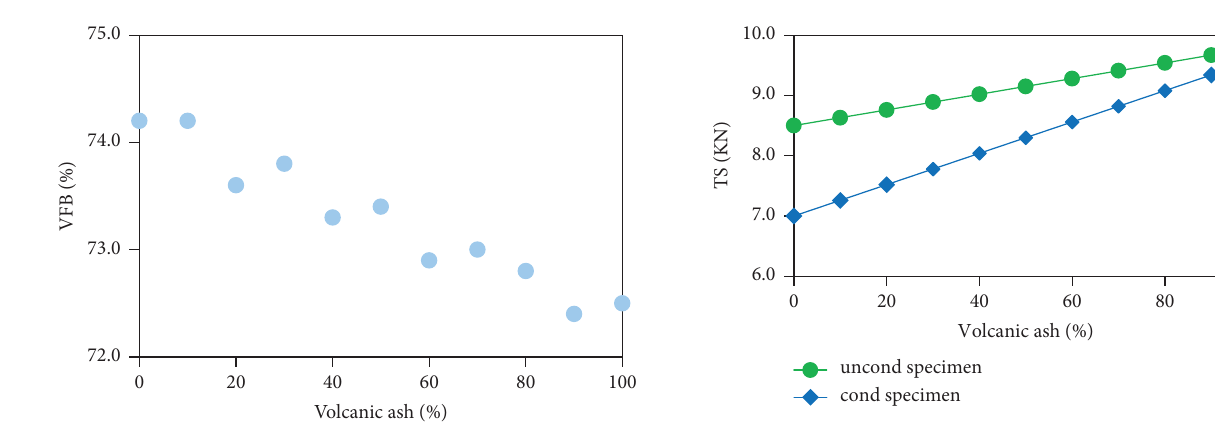
Figure 6: Impact of VA content on Marshall VFB of HMA.